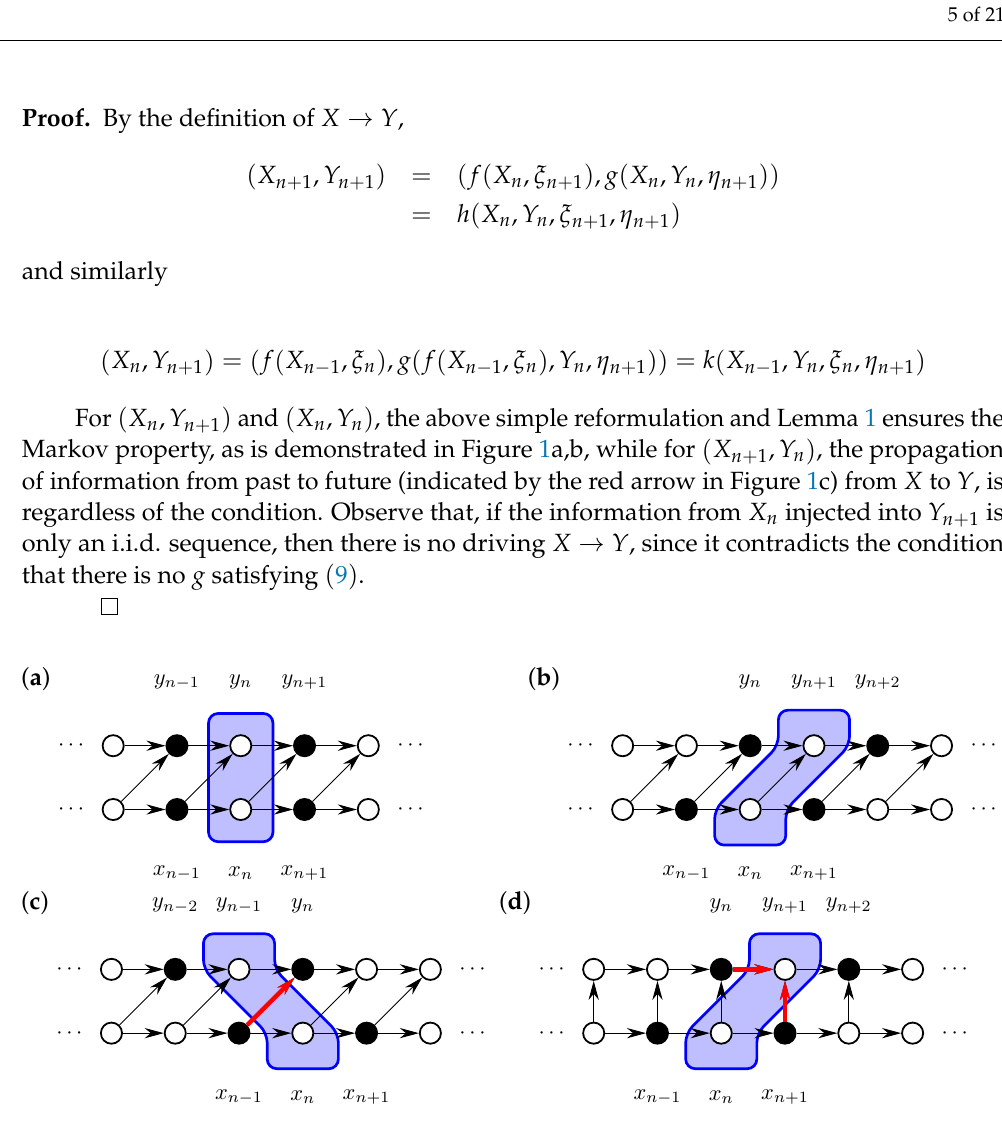
Figure 1. Markov property and unidirectional forcing. Conditional independence tests to test the Markov property under various lag configurations are illustrated. The condition is indicated by the shaded area, while the observations used in the dependence test are represented by filled